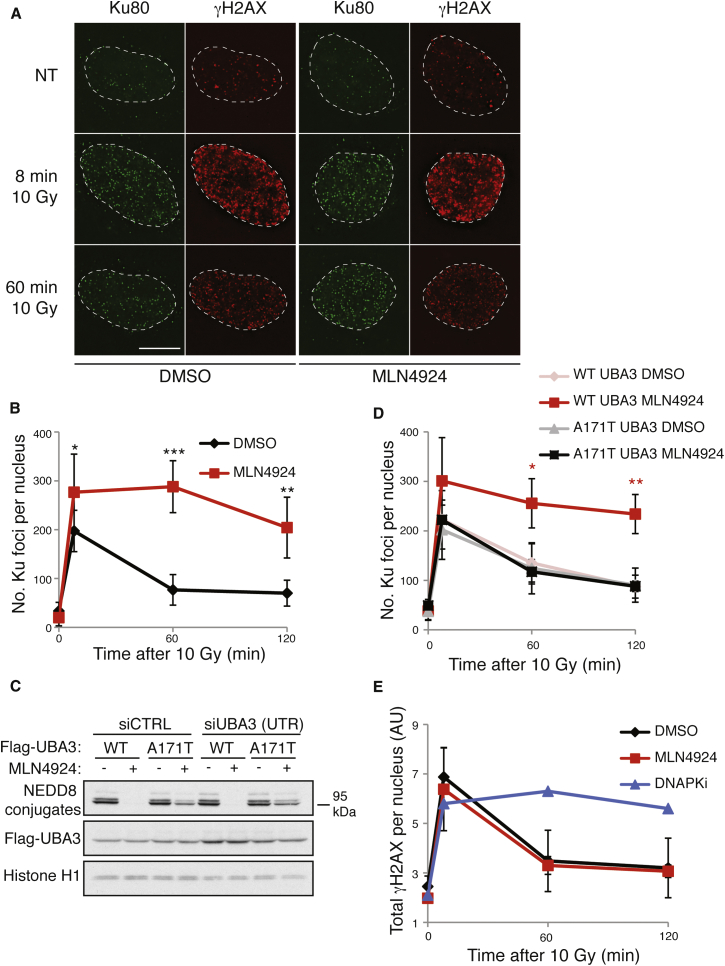
MLN4924 Inhibits Ku Removal from DNA Repair Sites(A and B) MLN4924 causes Ku80 foci persistence after IR. U2OS cells were pre-treated with DMSO or 3 μM MLN4924 for 1 hr and then subjected to 10 Gy IR. Samples were pre-extracted with CSK+RNase A and visualized by immunofluorescence. (A) shows representative images, and (B) shows quantification. Dotted lines indicate nuclear peripheries. Error bars correspond to SDs of at least three independent experiments (asterisks as in Figure 1B). White bar represents 10 μM.(C) U2OS-A171T UBA3 are resistant to MLN4924. U2OS cells stably expressing WT UBA3 or A171T UBA3 were treated with DMSO or 3 μM MLN4924 for 1 hr and analyzed by immunoblotting with indicated antibodies. Endogenous UBA3 was depleted with a siRNA to the 3′ UTR (Figure S2B). Neddylated conjugates are detected with a NEDD8-specific antibody.(D) MLN4924 effects on Ku80 foci retention are through UBA3 inhibition. U2OS cells stably expressing WT UBA3 or A171T UBA3 were processed as in (A), and results were quantified as in (B).(E) MLN4924 does not affect γH2AX recovery after IR. Quantification of total γH2AX intensity per nucleus in cells treated with 10 Gy IR then harvested at indicated times. Samples were prepared as in (A). Pre-treatment for 1 hr with 3 μM DNA-PK inhibitor (DNA-PKi) used as a positive control. Statistical analysis as in (B). AU, arbitrary units. See also Figure S2.